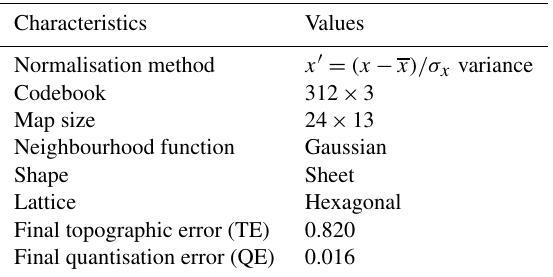
Table 3. Characteristics of trained Kohonen self-organising map (K–SOM)